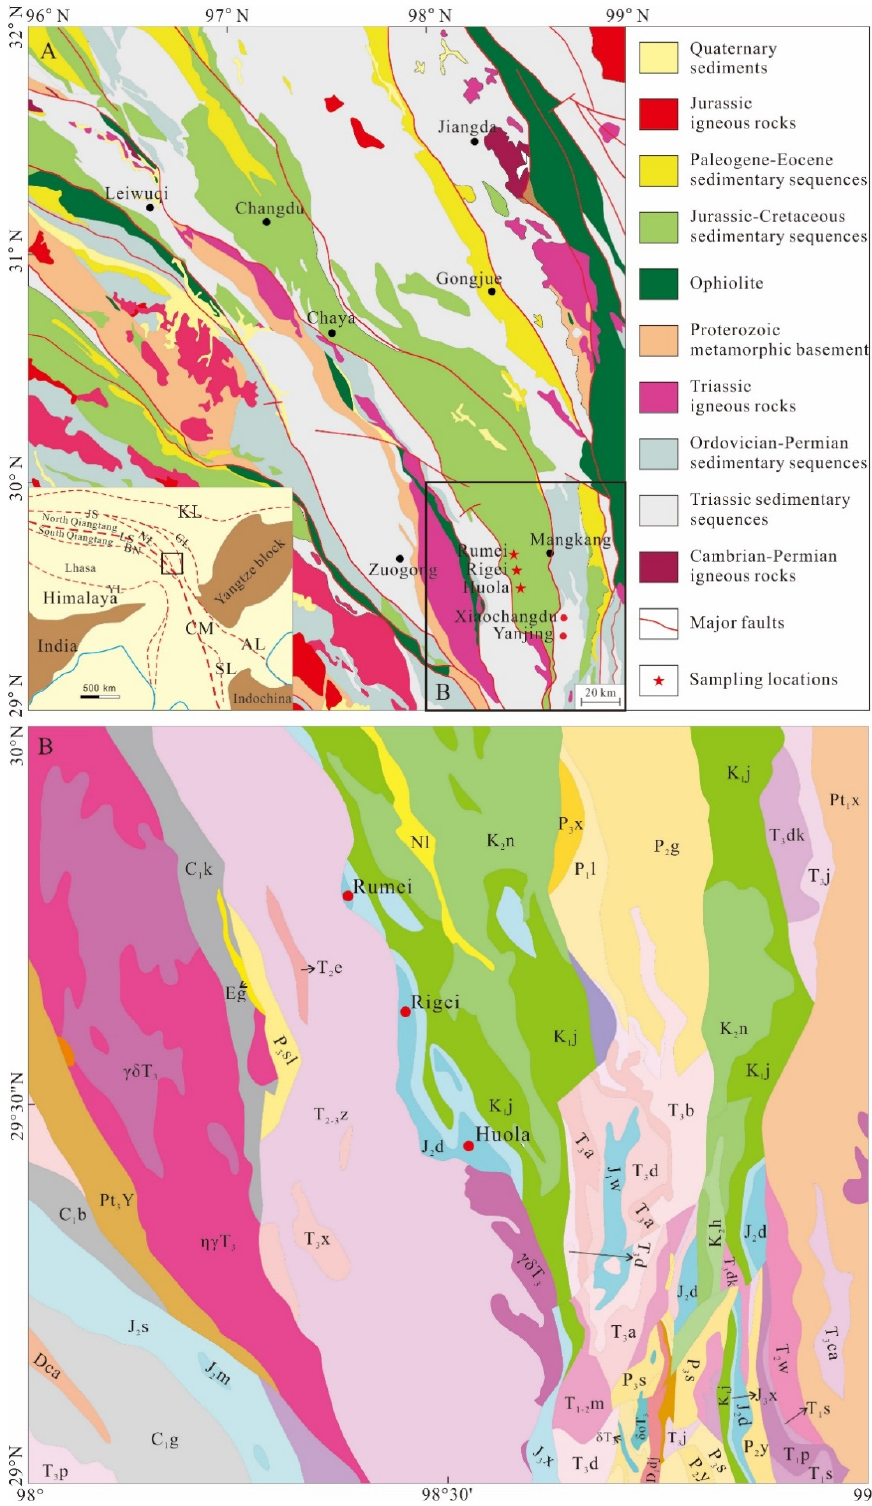
Figure 2. The schematic geologic map of the Qamdo Basin ( A , Modified from [15]), and the distribution of the Dongdaqiao Formation (J 2 d) ( B modified from [6]). KL: East Kunlun-A’nyemaqen suture, GL: Ganzi-Litang suture, JS: Jinshajiang suture, AL: Ailaoshan suture, NL: North Lancangjiang suture, SL: South Lancangjiang suture, LS: Longmu co-Shuanghu suture, CM: Changning-Menglian suture, BN: Bangong-Nujiang suture, YL: Indus-Yarlung Tsangpo suture.